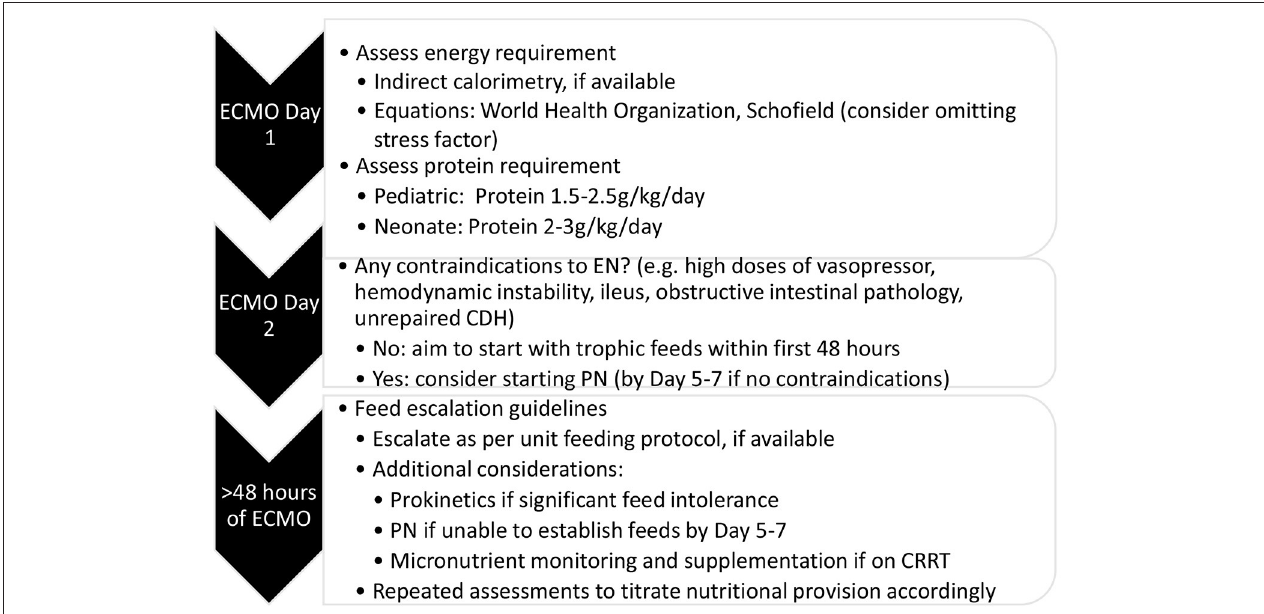
FIGURE 1 | Proposed approach for nutritional support in pediatric extracorporeal membrane oxygenation. CDH, congenital diaphragmatic hernia; EN, enteral nutrition; PN, parenteral nutrition; CRRT, continuous renal replacement therapy.